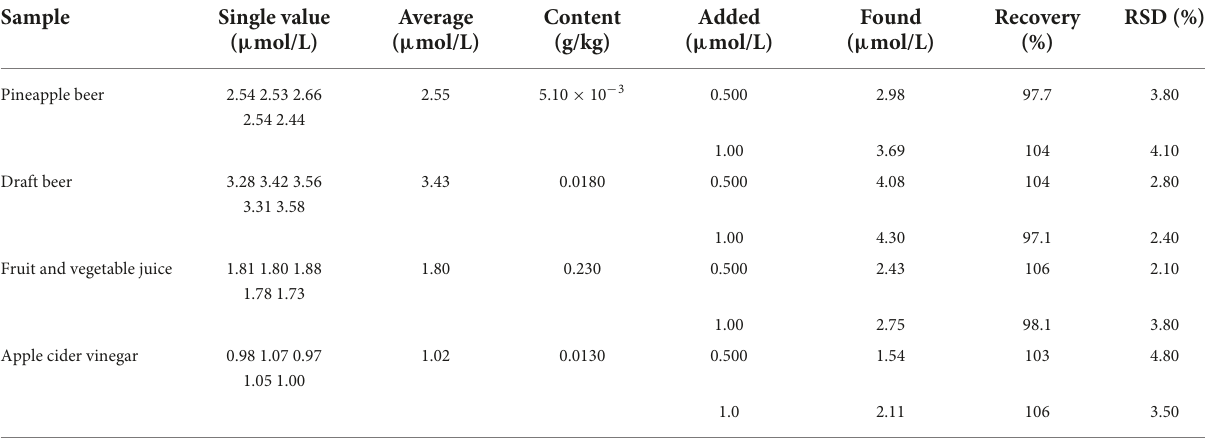
TABLE 2 Results for determination of SO 32 − in food